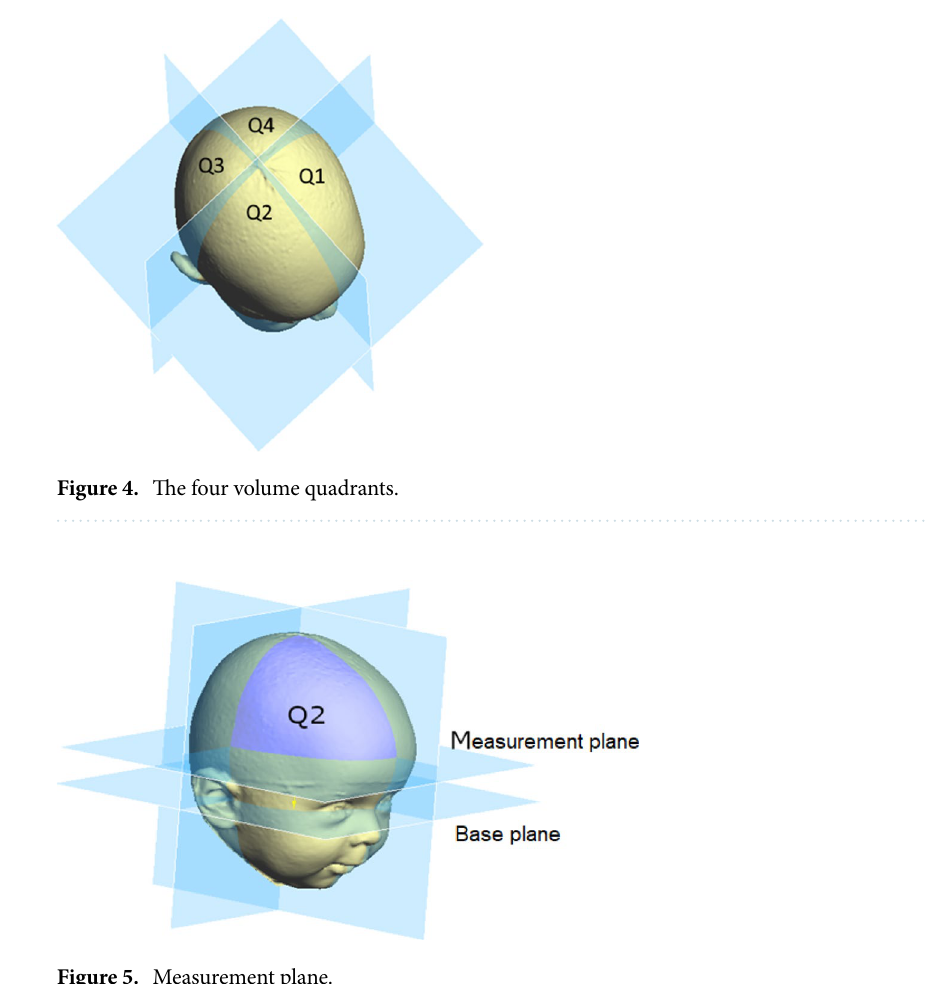
Figure 5. Measurement plane.